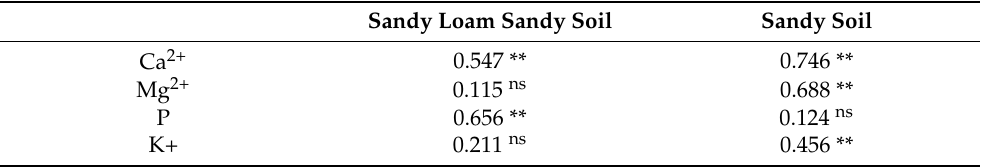
Table 4. The relationship of root length with soil Ca 2+ , Mg 2+ , P, and K + content under biostimulant condition from the two types of soils. Levels of significance are as follows: ns, not significant: ** p < 0.01.